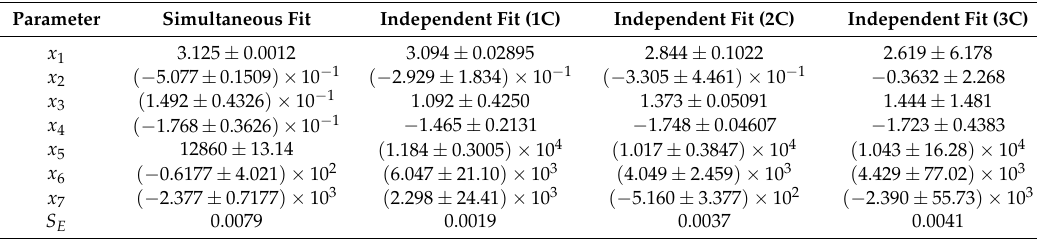
Table 3. Comparison of the 95% confidence intervals of x estimated from the simultaneous fit and the independent fit.